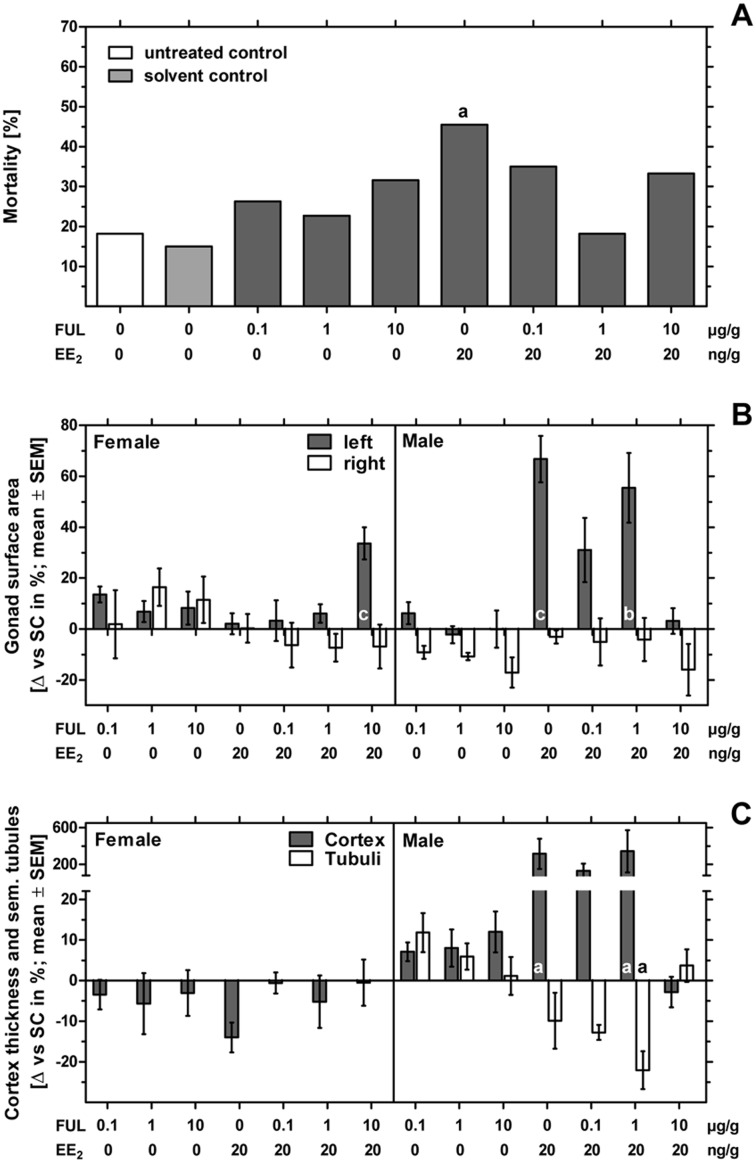
Effects of in ovo exposure to fulvestrant and 17α-ethinylestradiol on mortality, left and right gonad surface area, cortex thickness and percentage of seminiferous tubules of left gonad of embryos of the domestic fowl (Gallus g. domesticus).Effects of in ovo exposure to fulvestrant (FUL, 0.1, 1, 10 µg/g egg) and 17α-ethinylestradiol (EE2; 20 ng/g egg) on mortality (A), left and right gonad surface area (B) and cortex thickness and percentage of seminiferous tubules of left gonad (C) of embryos of the domestic fowl (Gallus g. domesticus) on embryonic day 19. Statistical analysis by Fisher’s exact test (A) and one-way ANOVA with Dunnett’s multiple comparison test (B, C). Grey background distinguishes the co-exposure to fulvestrant and EE2. Lowercase indicate significant differences compared to the solvent control. Level of significance: a: p < 0.05; b: p < 0.01; c: p < 0.001.